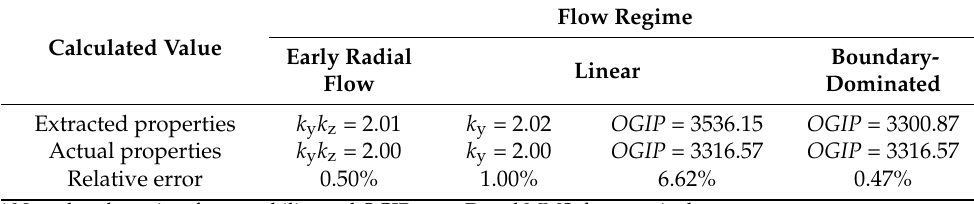
Table 4. Extracted properties * and relative errors of simulation examples using two phase (water + gas) RTA.